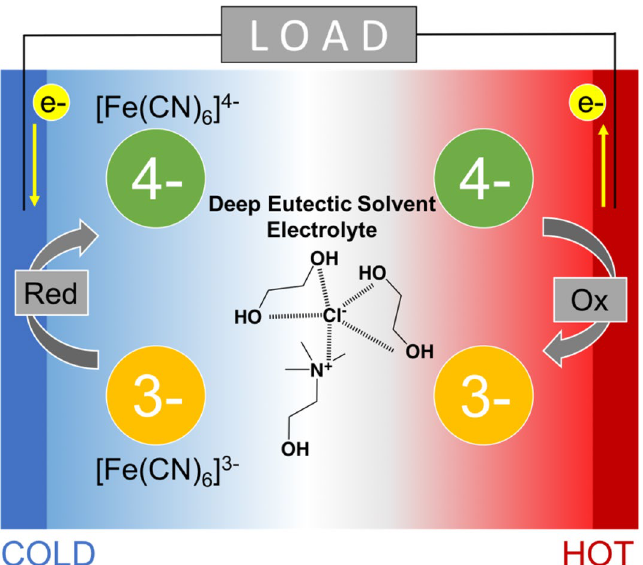
Figure 1. Schematic illustration of a [Fe(CN) 6 ] 4−/3− thermocell, which utilizes DES ethaline as an